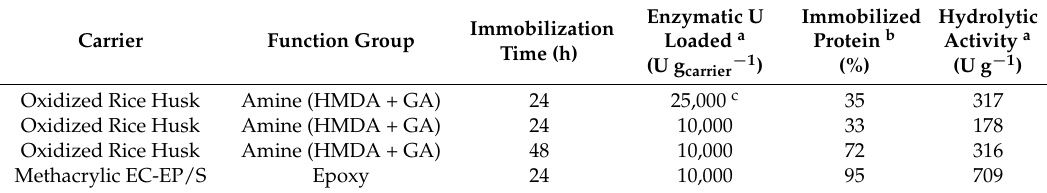
Table 2. Properties of different formulations of covalently immobilized CaLB.